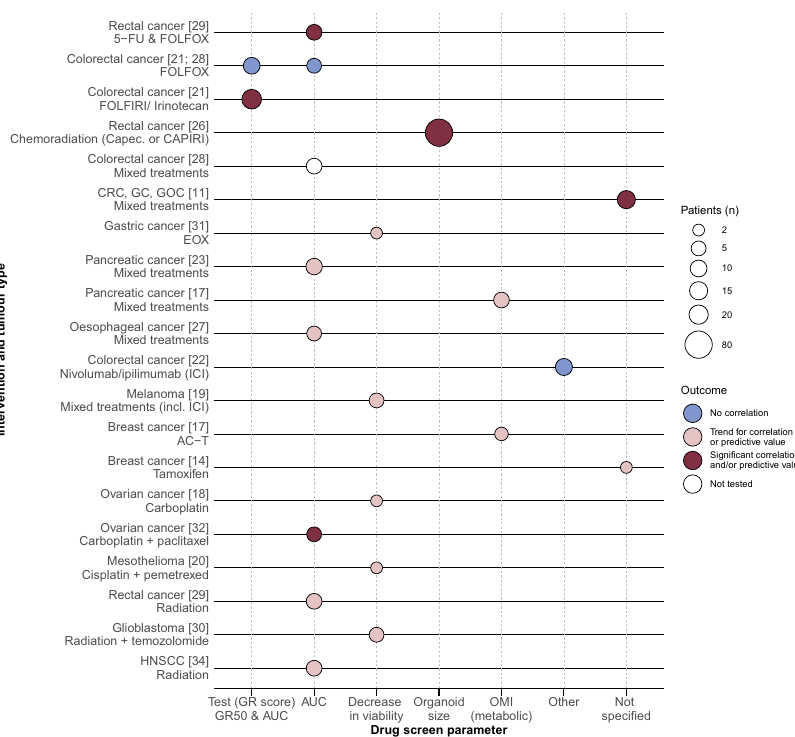
Fig. 2 Evidence landscape of PDO drug screen parameters and clinical response. Illustrates the clinical validity results for PDOs as a predictive biomarker for treatment response (dark red: signi fi cant correlation and/or predictive value found, pink: trend for correlation or predictive value found, blue: no correlation and white: not tested), with the size of the circle representing the patient cohort size, speci fi ed per treatment and tumour type ( y -axis) and ex vivo drug response parameter ( x -axis). Abbreviations: 5-FU 5- fl uorouracil, AC-T doxorubicin + cyclophosphamide + paclitaxel, AUC area under the curve, Capec . capecitabine, CAPIRI capecitabine + irinotecan, CRC colorectal cancer, EOX epirubicin + oxaliplatin + 5-FU, FOLFIRI 5-FU + irinotecan, FOLFOX 5-FU + oxaliplatin, GC gastric cancer, GOC gastroesophageal cancer, GR growth rate inhibition metrics, GR50 value with 50% viable GR, HNSCC head and neck squamous cell carcinoma, ICI immune checkpoint inhibitors, OMI optical metabolic imaging, PDO patient-derived drug screens. One aspect which may have in fl uenced the con fl icting results between the Ganesh et al. study and the TUMOROID and APOLLO trials is the choice of solvent used to dissolve oxaliplatin for the PDO drug screens, since this is known to affect the activity of oxaliplatin 35 .